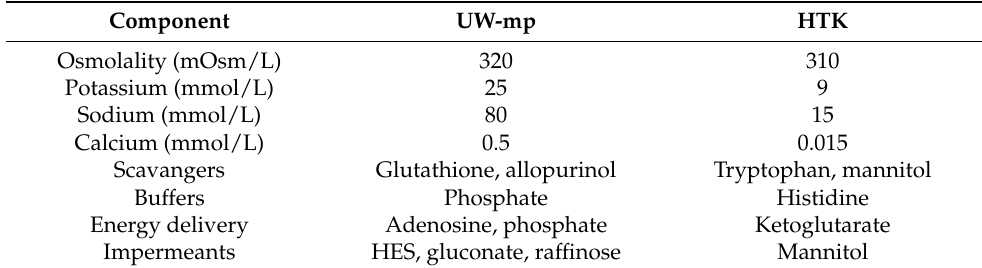
Table 1. Composition of UW-mp and HTK